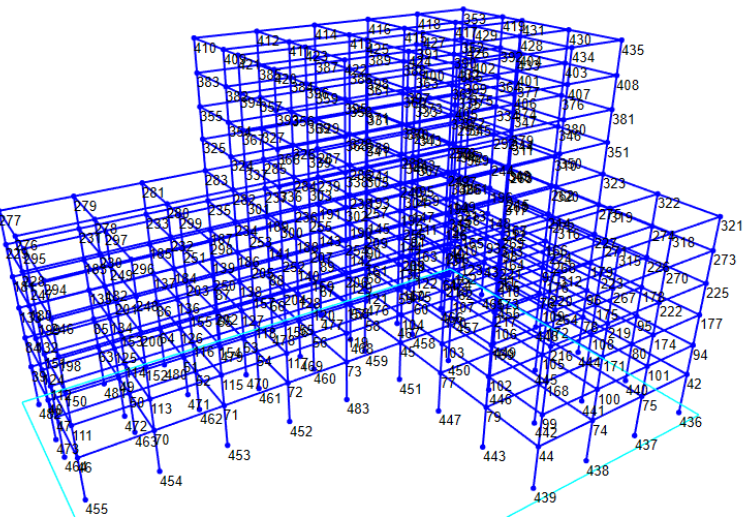
Figure 3. The spatial structure model with node numbers in SAP2000.